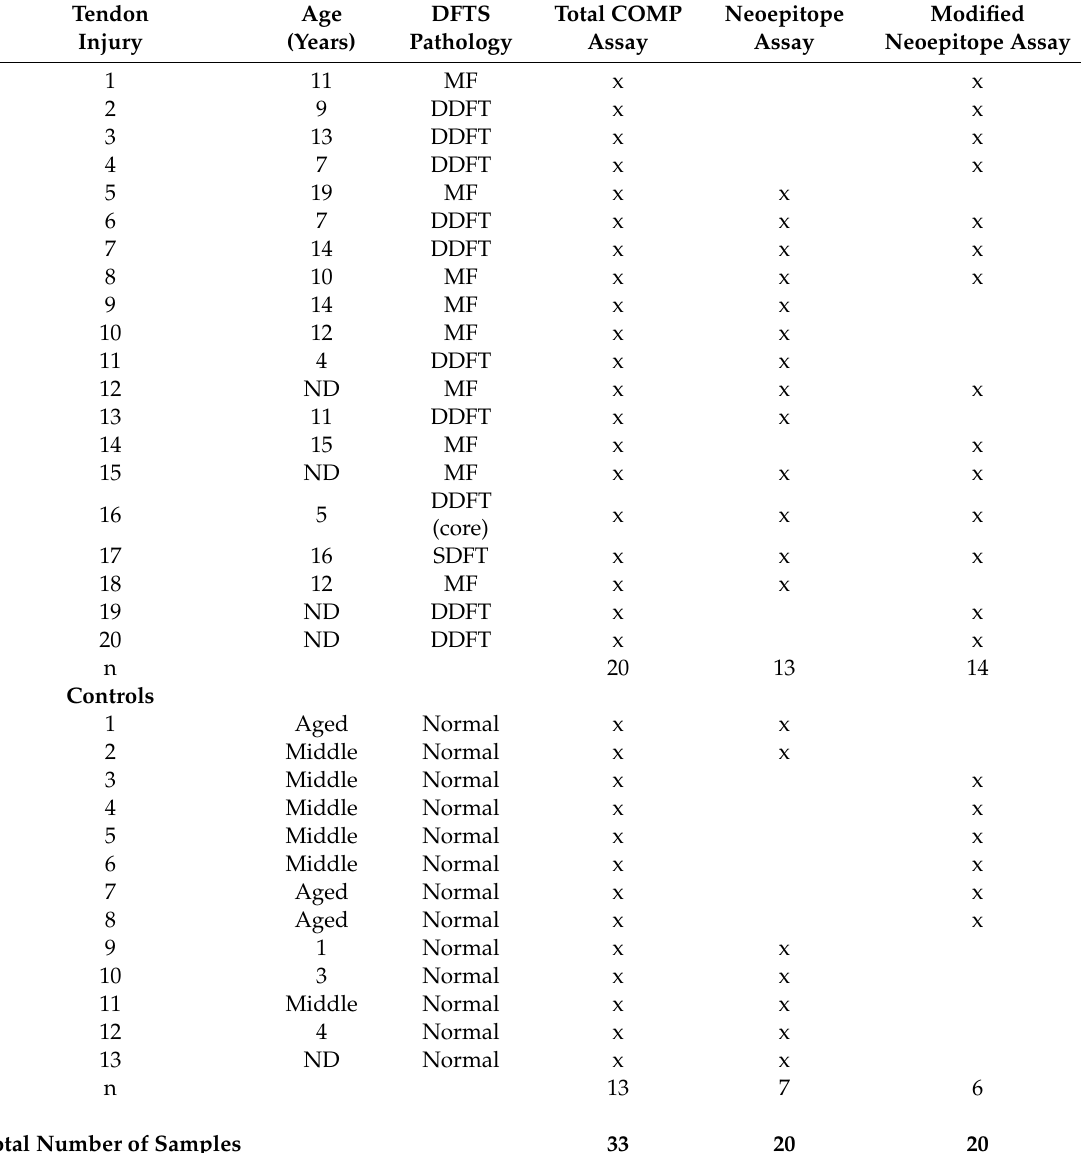
Table 1. Details of the 33 digital flexor tendon sheath (DFTS) synovial fluid samples analyzed with the three di ff erent